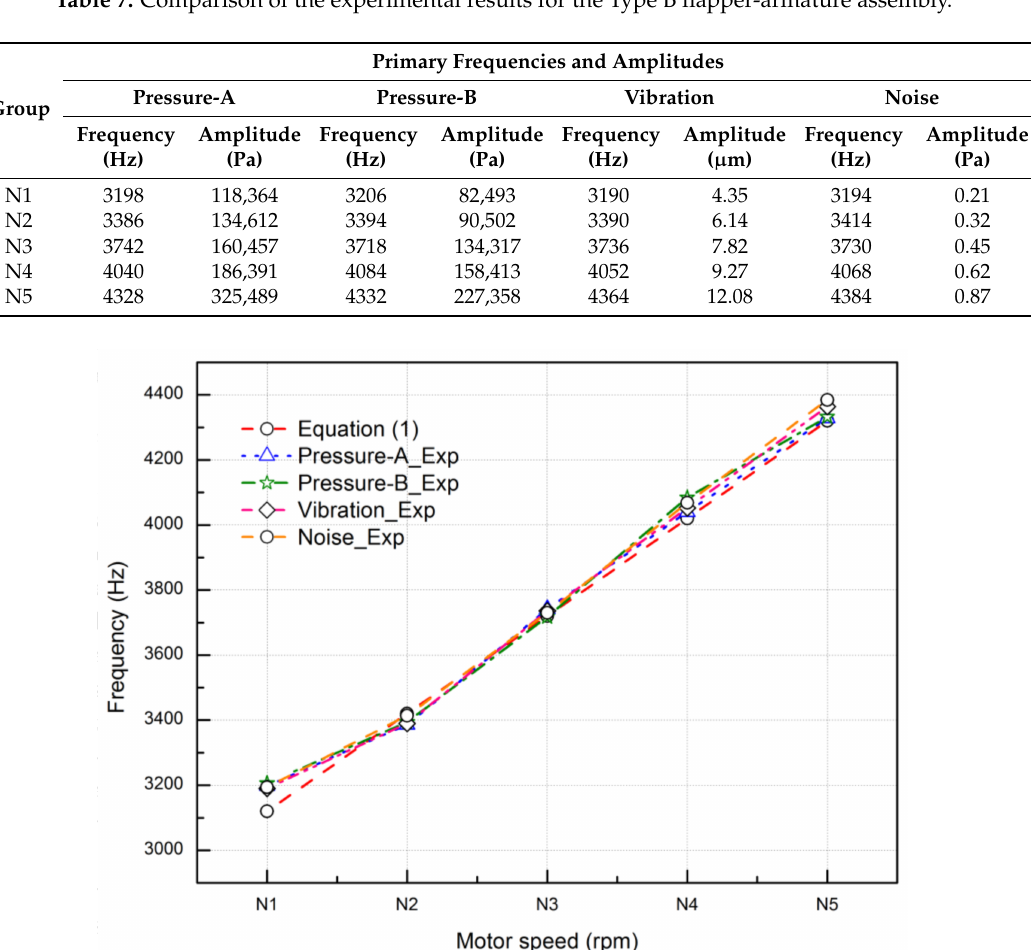
Figure 14. Comparison of the primary frequencies between the calculated and experimental results for the Type B flapper-armature